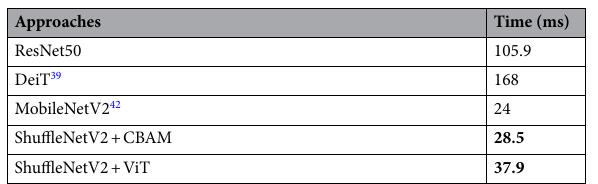
Table 4. Comparing the time to identify a single sentiment sample by different network models. The test results of our proposed method are shown in bold.